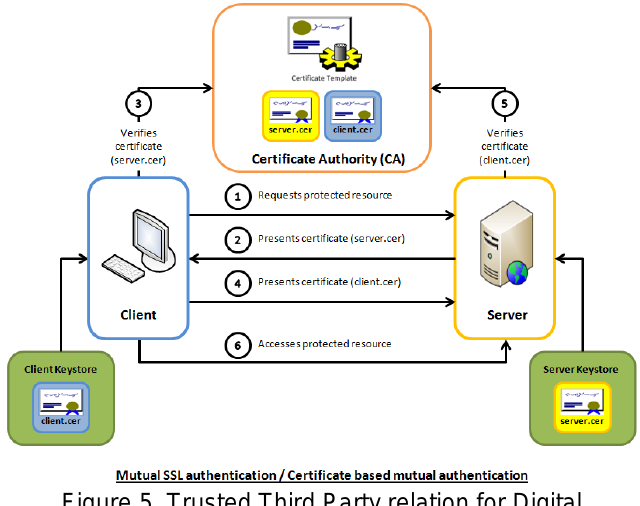
Figure 5. Trusted Third Party relation for Digital